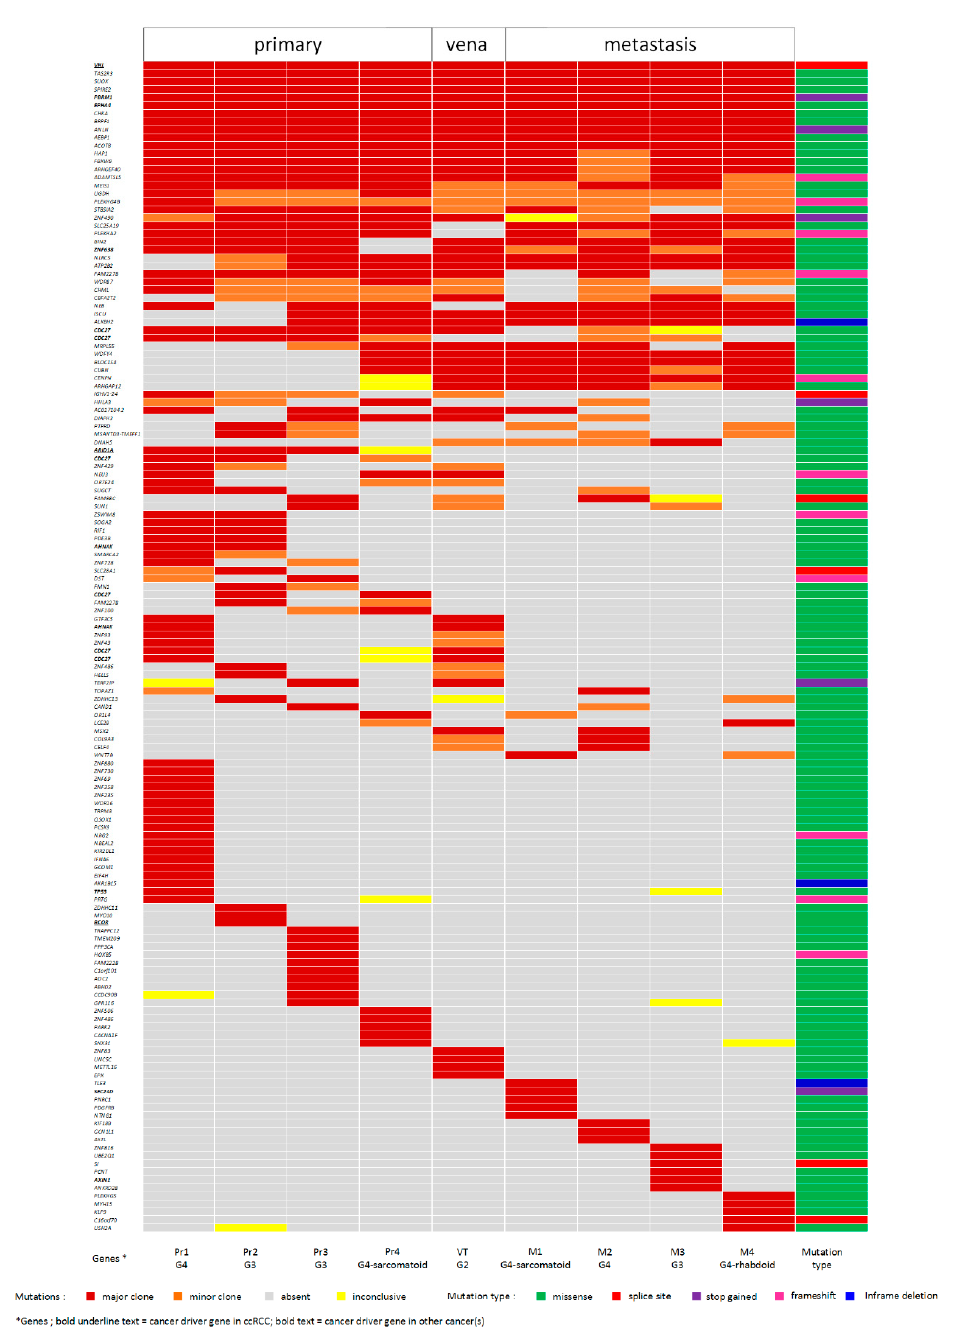
Figure 3. Somatic mutations identified in multiple regions of the primary tumour and metastases detected by whole exome sequencing (WES). The somatic mutations were classified as major or minor clonal as described in the Material and Methods section. Classification of mutations is indicated by the colours in the legend. The somatic mutations encompass 138 genes, including 11 cancer driver genes, as highlighted at the bottom of the figure. Abbreviations: Pr1, primary tumour 1; Pr2, primary tumour 2; Pr3, primary tumour 3; Pr4, primary tumour 4; VT, inferior vena cava tumour thrombus; M1, metastasis 1; M2, metastasis 2; M3, metastasis 3; M4, metastasis 4; G2, tumour grade 2; G3, tumour grade 3; G4, tumour grade